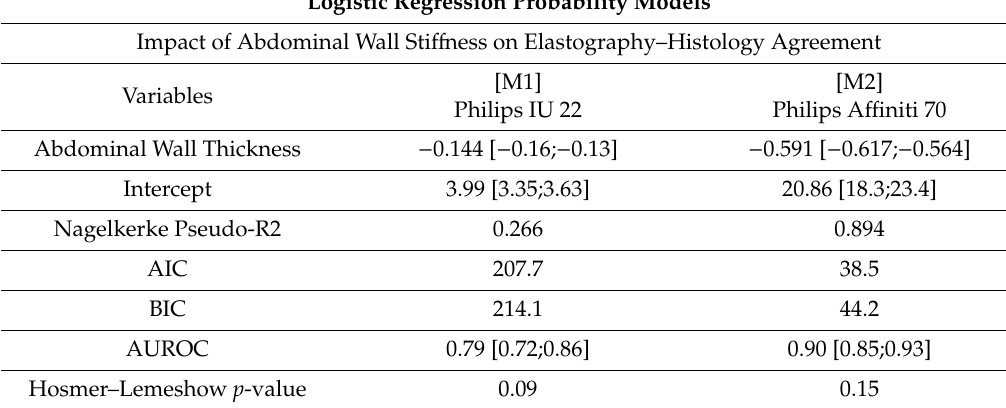
Table 3. Logistic regression models metrics. Values are regression coe ffi cients and robust 95% confidence intervals from logistic regression and model discriminative and calibration metrics. Logistic Regression Probability Models Impact of Abdominal Wall Sti ff ness on Elastography–Histology